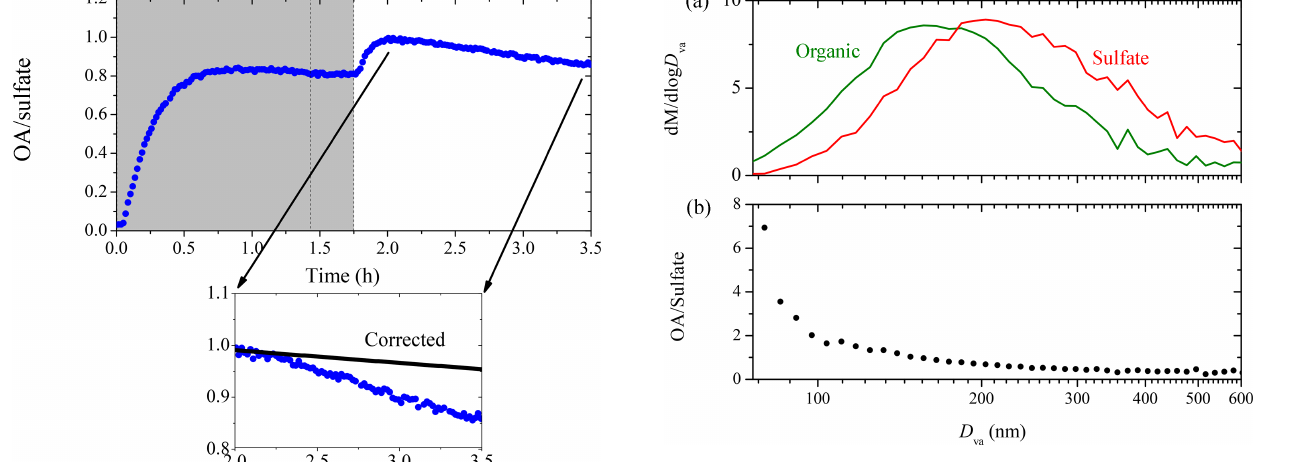
Figure 6. The organic to sulfate ratio time series derived from AMS measurements for Exp. 4 (data after the second HONO introduc- tion are not shown). The inset is a blow-up of the OA / sulfate ratio from its maximum until the second HONO introduction. The black symbols are the size-dependence-corrected OA / sulfate during that 1.5h. The shaded area indicates that the chamber was dark. The dashed lines mark the beginning and the end of the first HONO in- jection into the chamber.